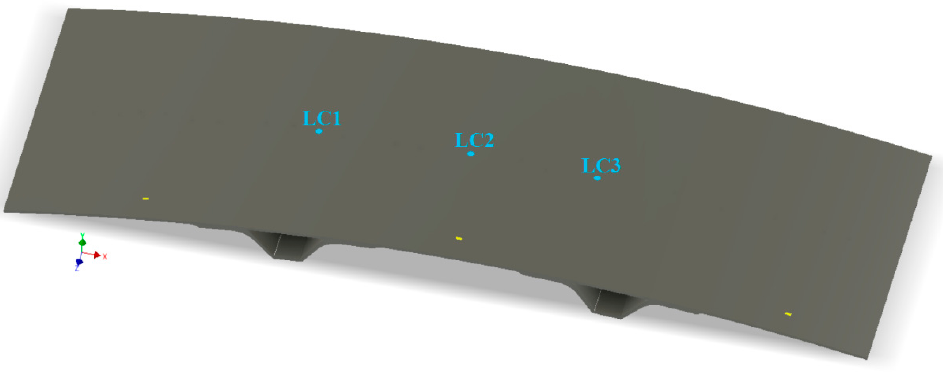
Figure 6. Load points in experimental verification.